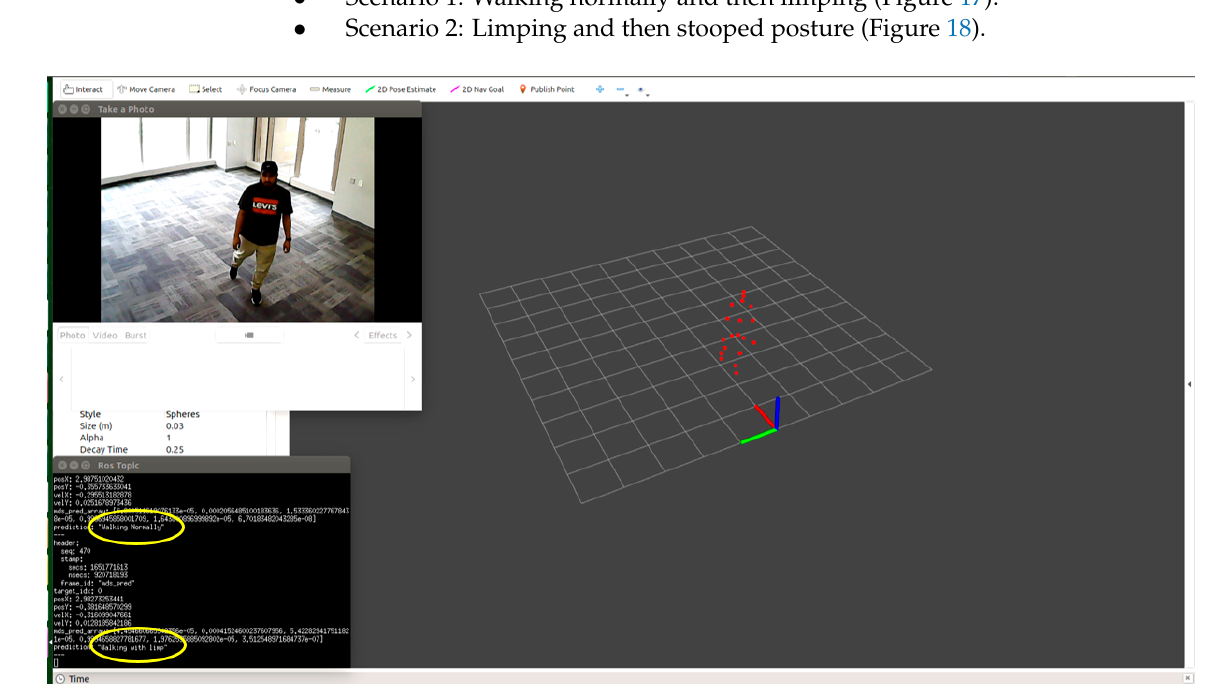
Figure 17. Walking normally and then limping.